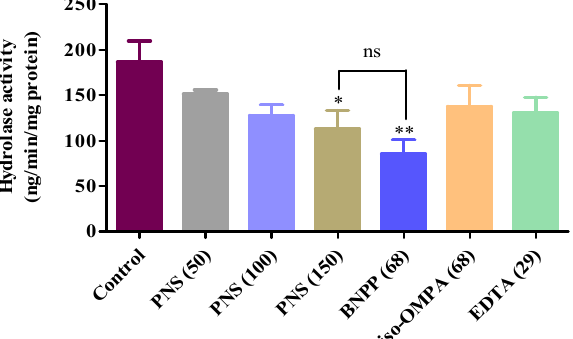
Figure 7. Hydrolysis of aspirin (ASA) in HepaRG cell homogenates treated with PNS. HepaRG cells homogenates were prepared and then diluted with 50 mM HEPES buffer (pH 7.4). Hydrolysis of ASA (1.8 µg/mL) in cell homogenates was conducted in the presence/absence of PNS. No significance (ns) was detected between BNPP (68 µg/mL) and PNS (150 µg/mL) treated group. Data were presented as mean ± SD ( n = 3). *, and ** denoted results significantly different compared with the control group ( p < 0.05, p < 0.01, respectively).